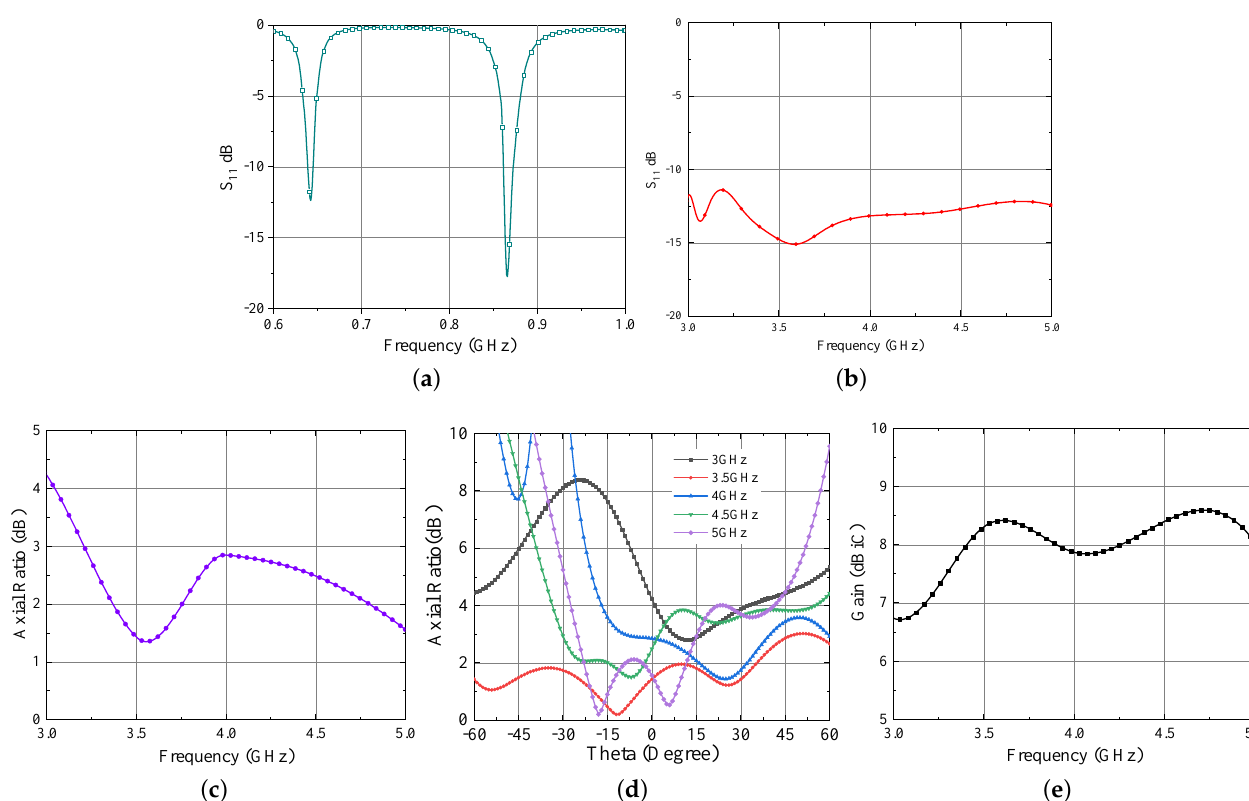
Figure 17. Simulated responses of hybrid UWB antenna ( a ) S 11 for UHF band (normalized to 12 Ω ) ( b ) S 11 for UWB band (normalized to 120 Ω ) ( c ) Axial Ratio v/s Freq ( d ) Axial Ratio v/s Theta ( e )